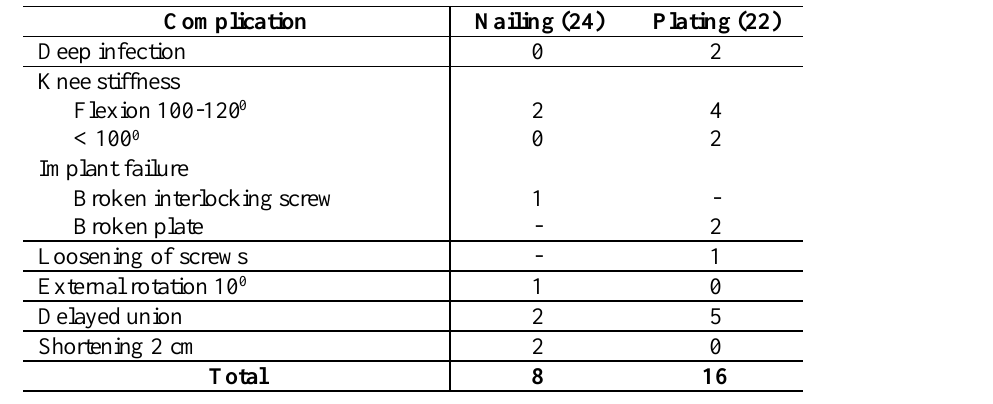
Table IV : Postoperative